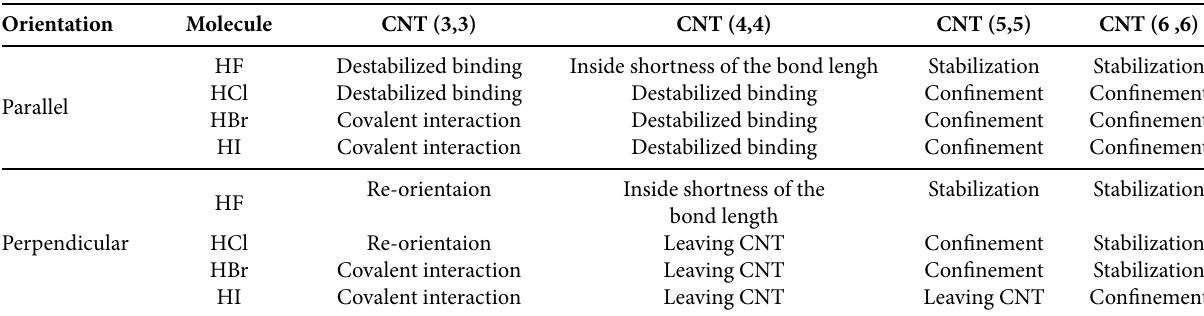
Table 1. Observed phenomena inside the studied nanotubes at parallel and perpendicular orientations Orientation Destabilized binding Inside shortness of the bond lengh Parallel